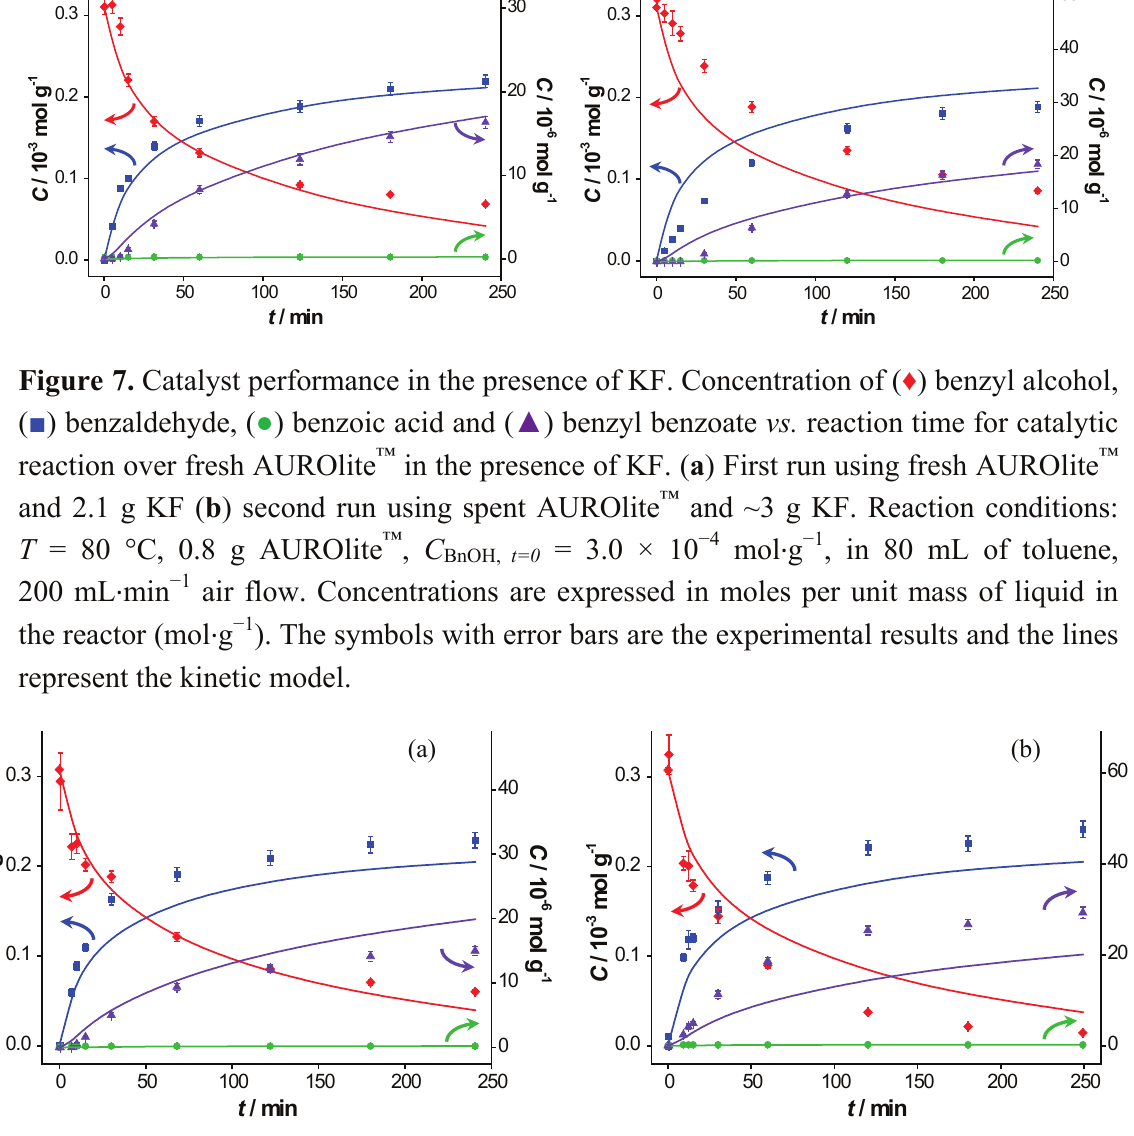
AUROlite ™ , 3.04 g K